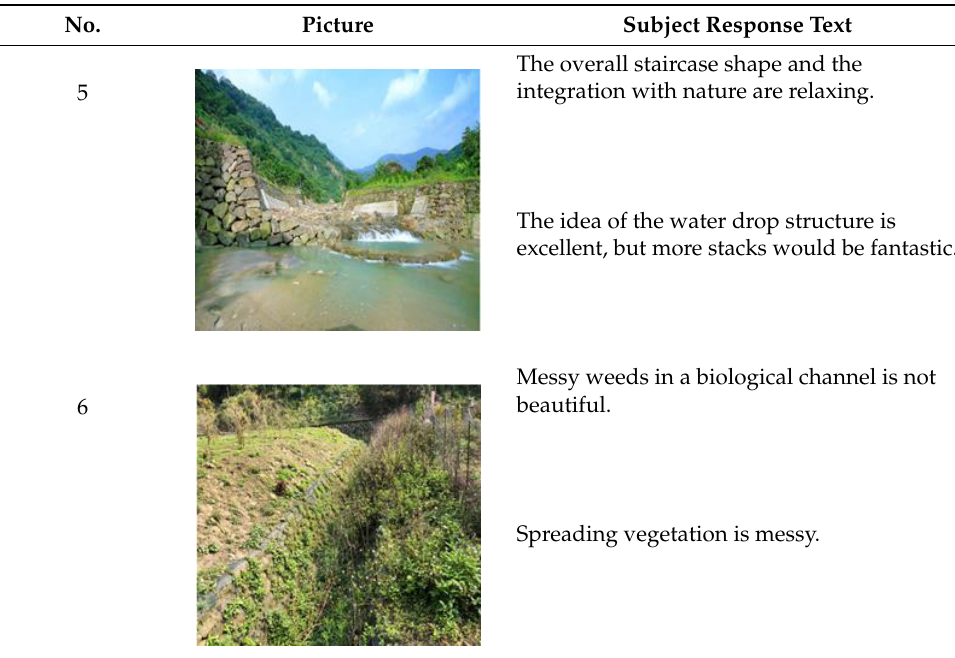
Table 10. CEM comparison of the highest and lowest SBE value images of the “Upstream Renovation Project of Toubiankeng Stream”.